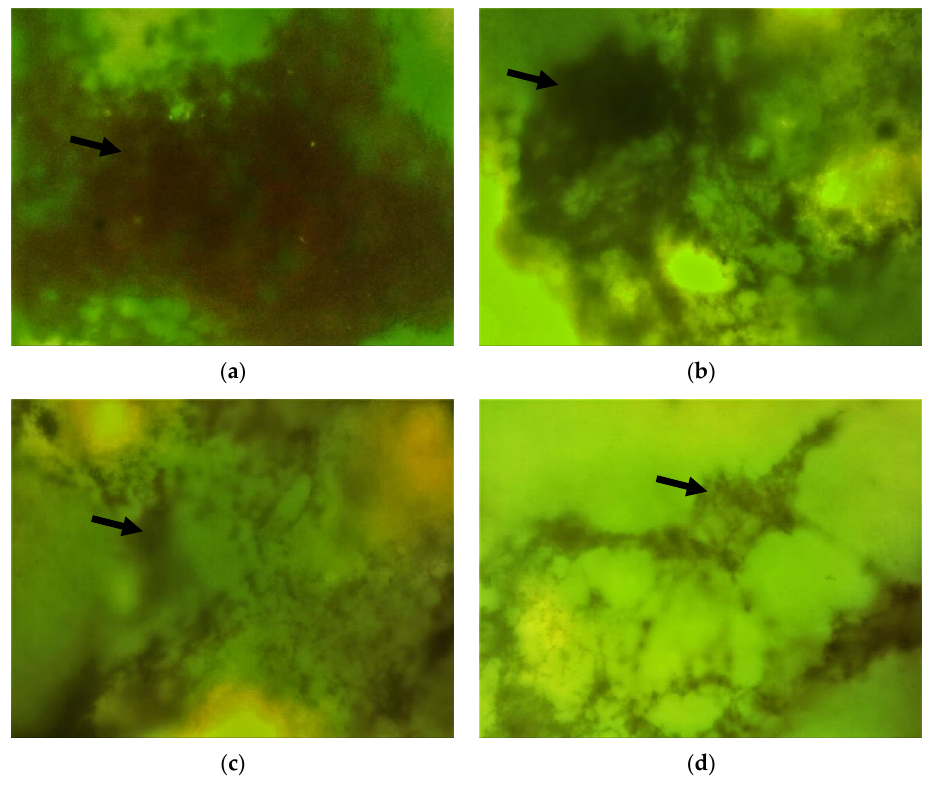
Figure 4. Fluorescent microscopy images showing EPS production (maroon-stained indicated by arrow) in the biofilms of the various treated samples: ( a ) saline; ( b ) herbal extracts; ( c ) combined herbal extracts and hydroxyethyl cellulose; and ( d ) chlorhexidine.